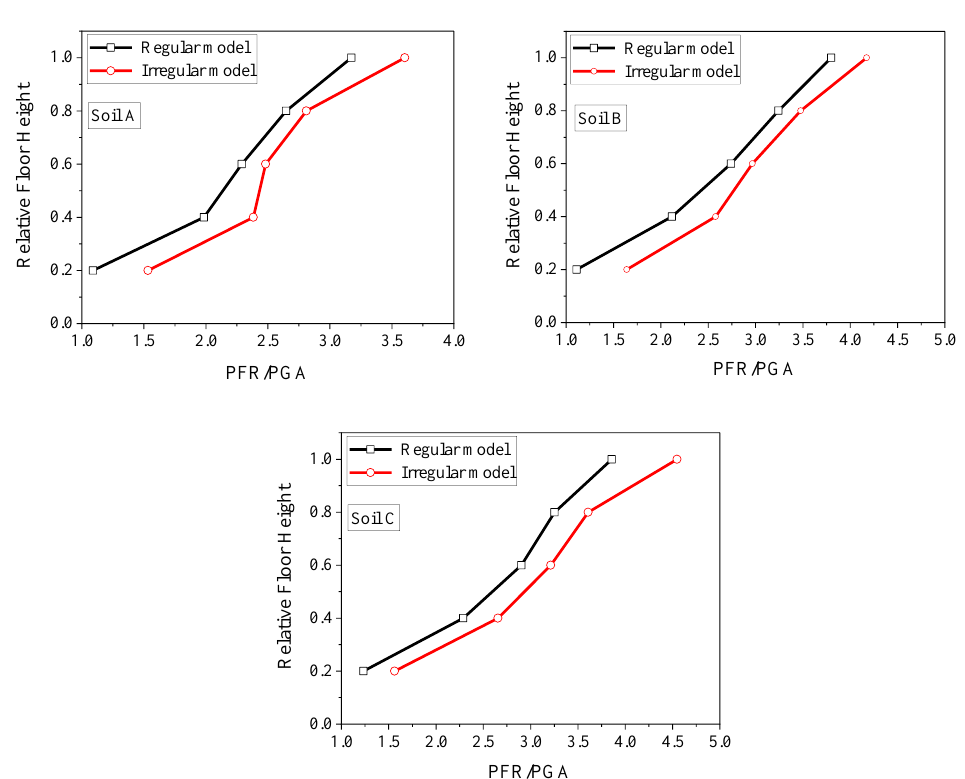
Figure 9. Comparison of normalized floor amplification between regular and irregular buildings for different soil types.